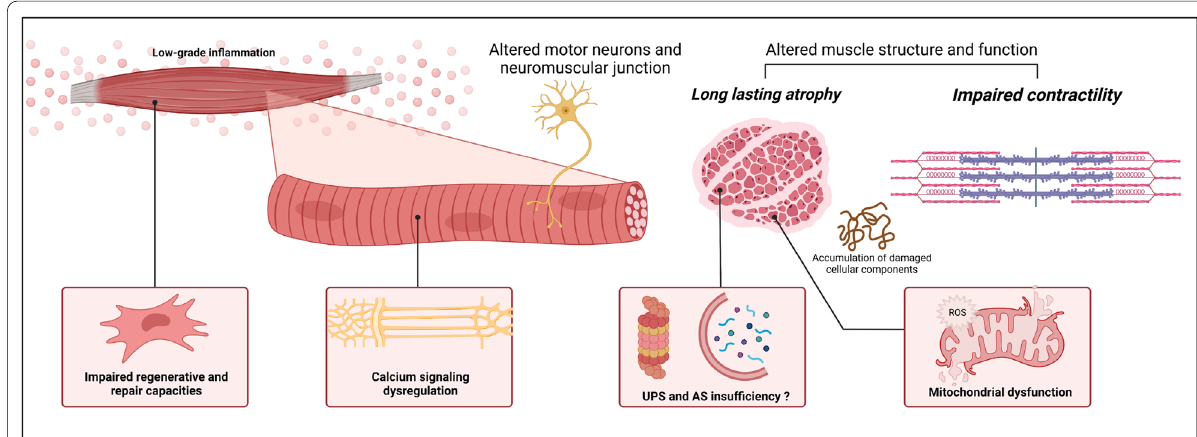
Fig. 2 Putative mechanisms of intensive care unit ‐ acquired